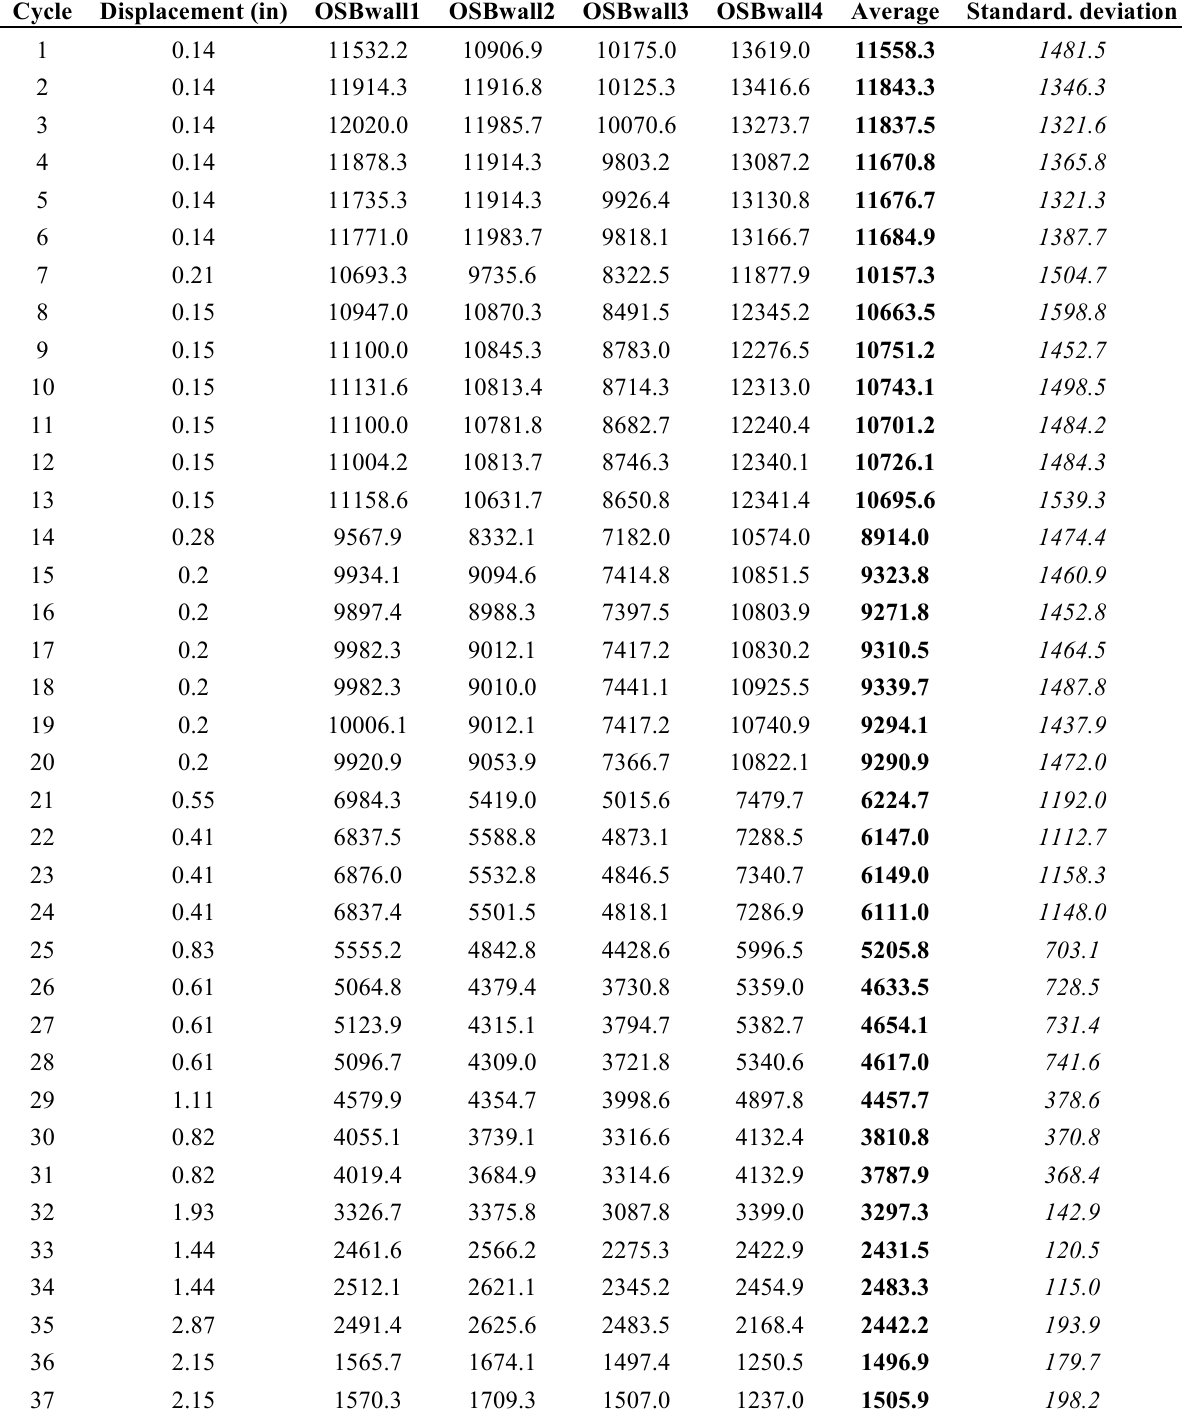
Table 4. Stiffness (lb/in) of